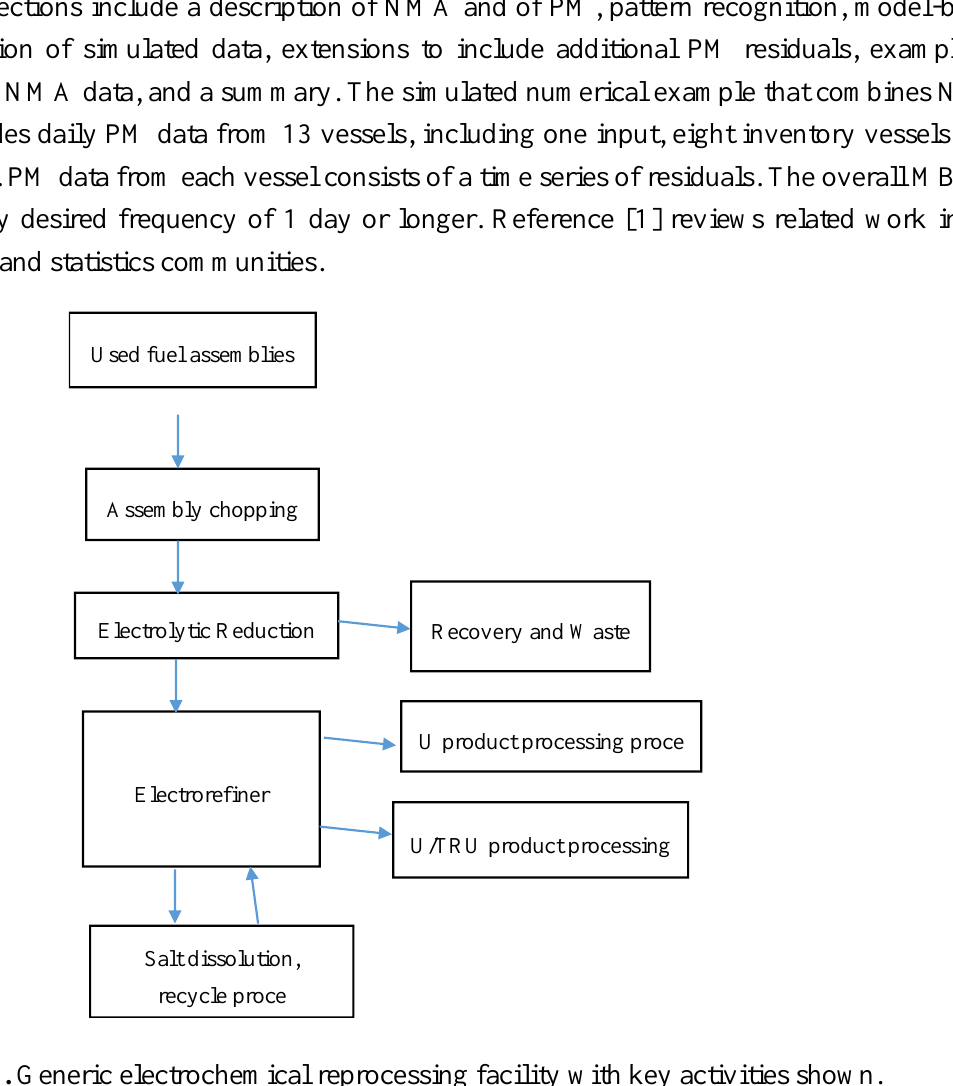
Figure 1. Generic electrochemical reprocessing facility with key activities